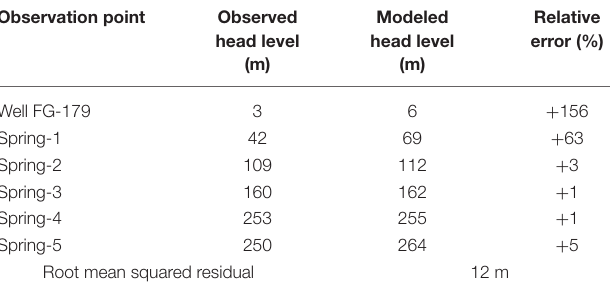
TABLE 4 | Observed streamflow under baseflow conditions assuming no additional surface runoff contribution, in comparison to modeled baseflow